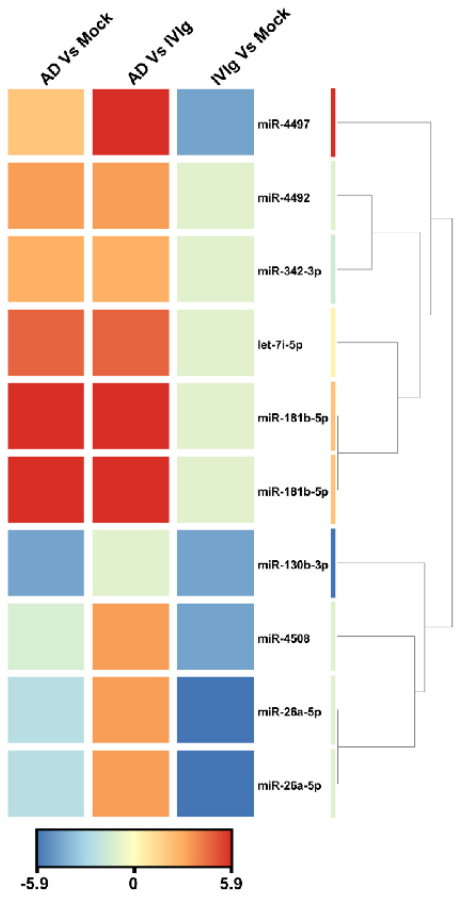
Figure 4. Unsupervised hierarchical clustering of significantly dysregulated miRNAs and sam- ples from the Illumina deep sequencing data. The heat map contains 10 miRNAs differentially expressed in AD vs. Mock control, AD vs. IVIg, and IVIg vs. mock control. The miRNA clustering tree is displayed on the right. The color scale indicates the relative expression levels of miRNA across all samples. Red indicates that the expression levels are higher than the mean, whereas blue indicates that the expression levels are lower than the mean. Each row represents one mature miRNA, and each column represents one sample. AD: thymocytes stimulated by IgG from patients with atopic dermatitis; IVIg: thymocytes stimulated by therapeutic intravenous IgG.